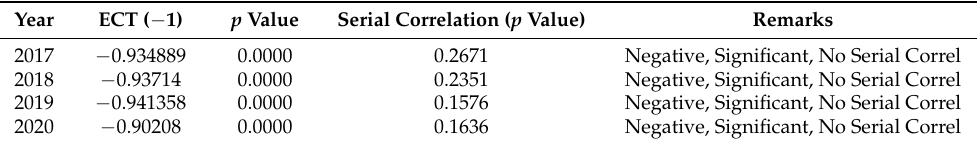
Table 6. ARDL and serial correlation after removing DPERFORMANCE ( −